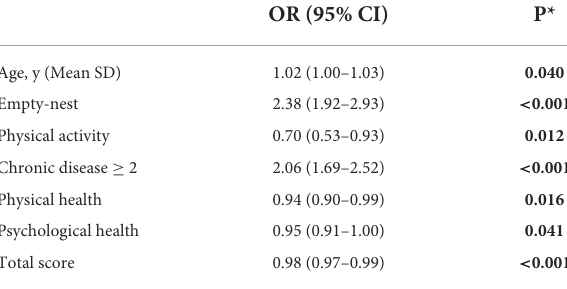
TABLE 3 Multivariable models showing factors associated with GDS-15 ≥ 5 among all